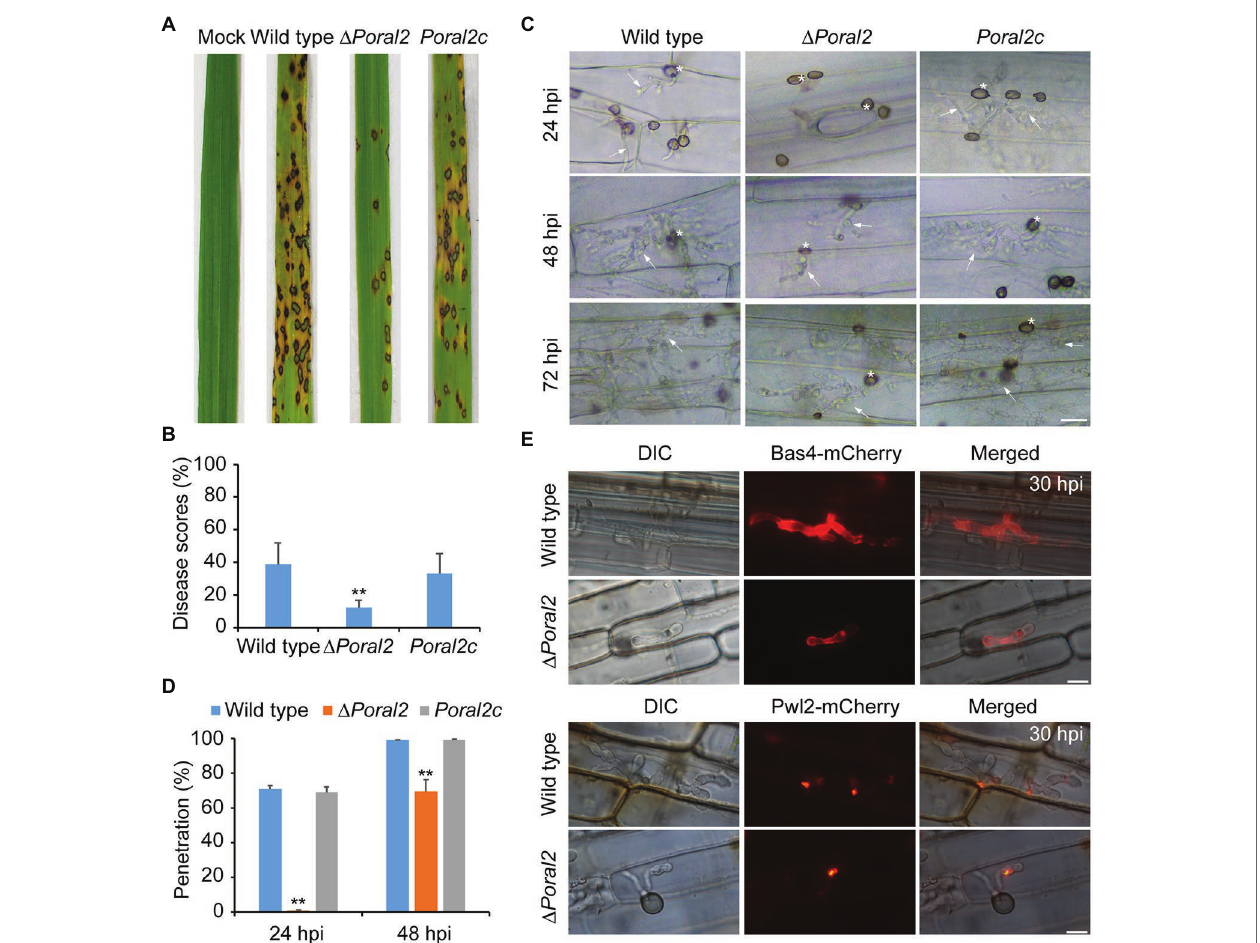
FIGURE 6 | Virulence and plant penetration assays. (A) Conidial suspensions (5 × 10 4 conidia/ml) were sprayed onto 14-day-old rice seedlings and cultured for 2 days in darkness at 22 ° C and 4 days under a 16:8-h light/dark cycle at 25 ° C. (B) Disease scores for the wild-type, ∆ Poral2 , and Poral2c strains were measured with 5-cm leaf length by Photoshop CS6. (C) Penetration and invasive growth in barley leaves at 24, 48, and 72 hpi. Bar = 20 μ m. Asterisks indicate appressoria, and arrows indicate invasive hyphae. (D) Penetration rate (%) of P. oryzae appressoria at 24 and 48 hpi. 20 μ l of conidial suspensions (5 × 10 4 conidia/ml) was inoculated onto intact barley leaves at 25 ° C. (E) Location of Bas4-mCherry and Pwl2-mCherry-NLS in wild-type and ∆ Poral2 strains in leaf sheaths at 30 hpi. Bar = 10 μ m. (B,D) Error bars represent standard deviations. Significant differences compared with the wild type were estimated by Tukey’s HSD test: * p < 0.05 and ** p <